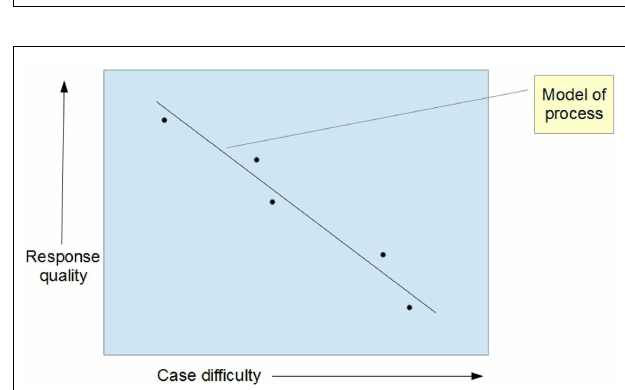
FIGURE 2 | Relation between the difficulty of the case and the quality of the response produced by the network